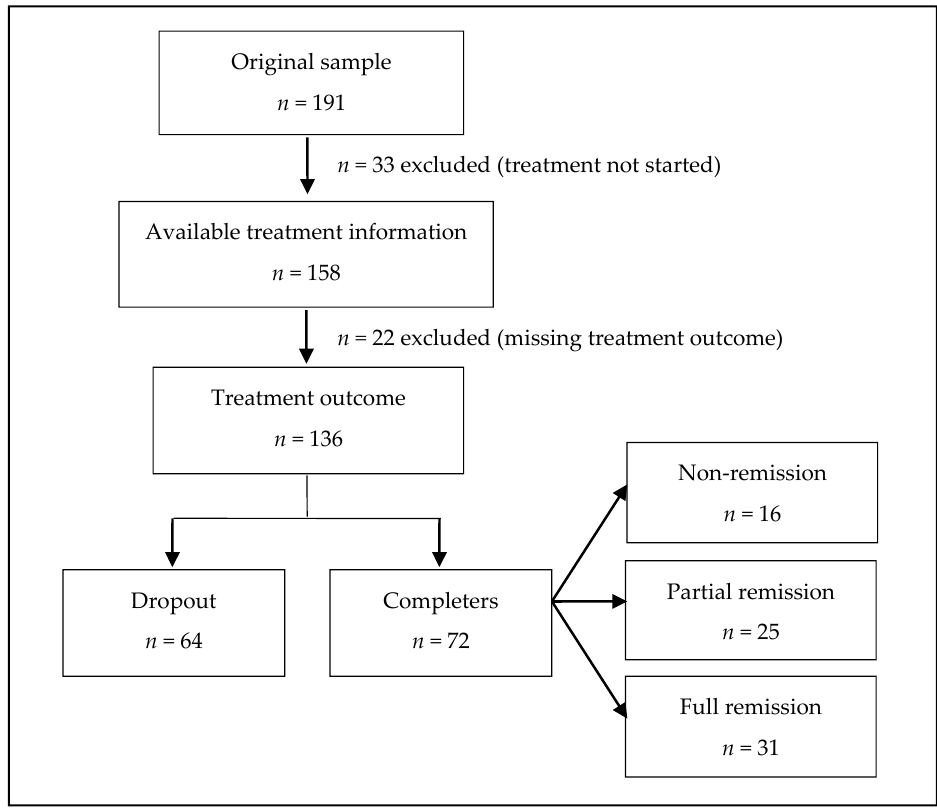
Figure 1. Flow chart for the sampling procedure.